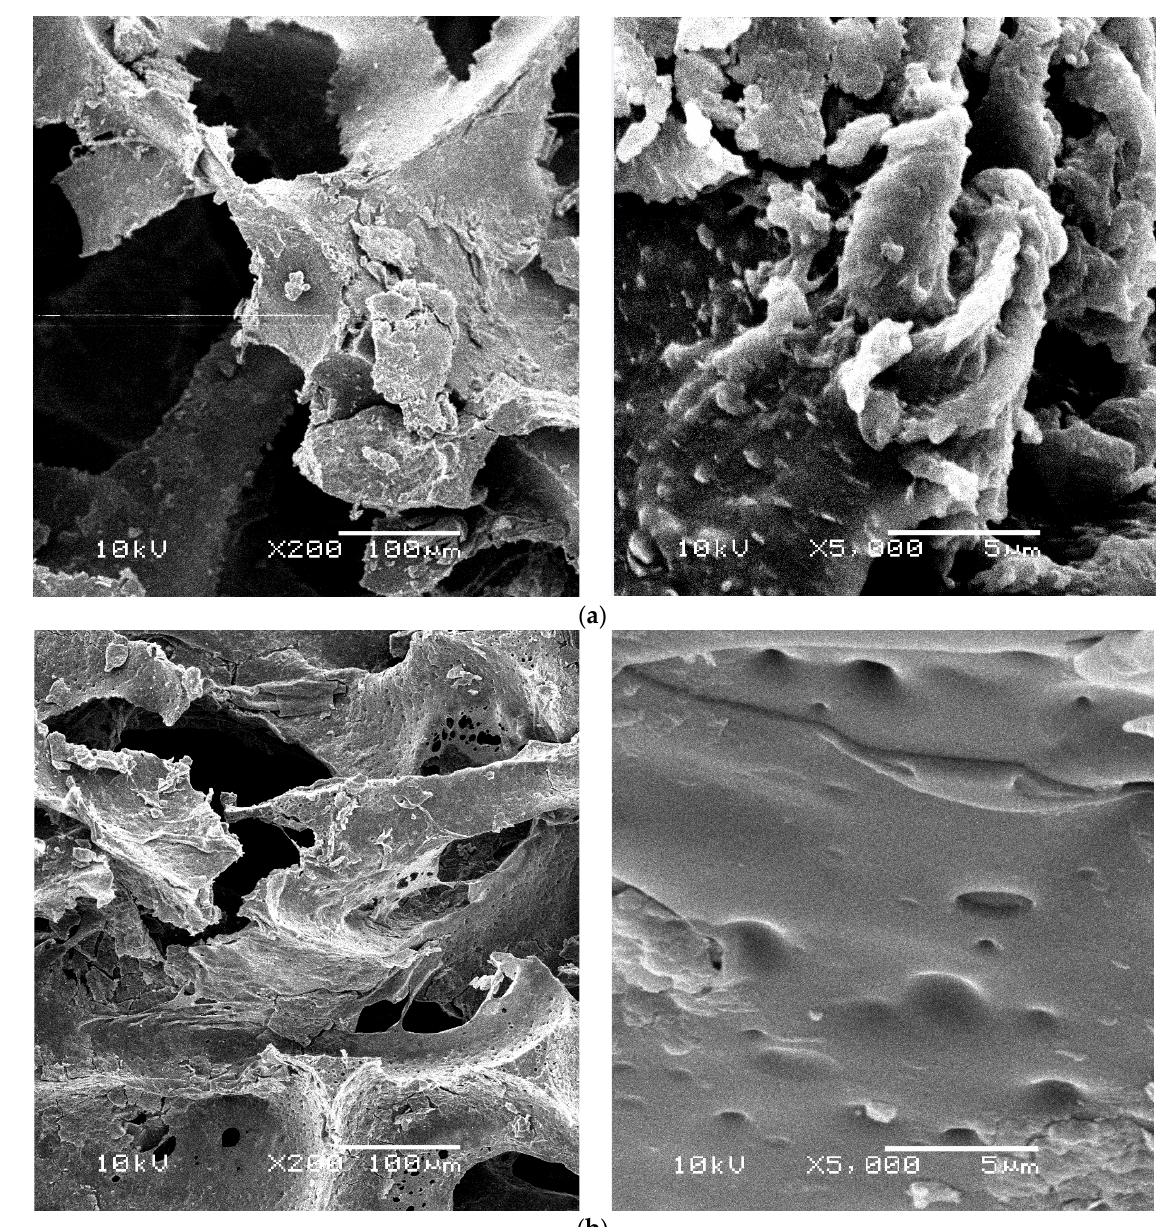
Figure 5. The SEM images for a cross-section of PUFs, ( a ) orange; ( b ) lilac (arrows indicate fluffy biomass fb; single colonies of bacteria sc).